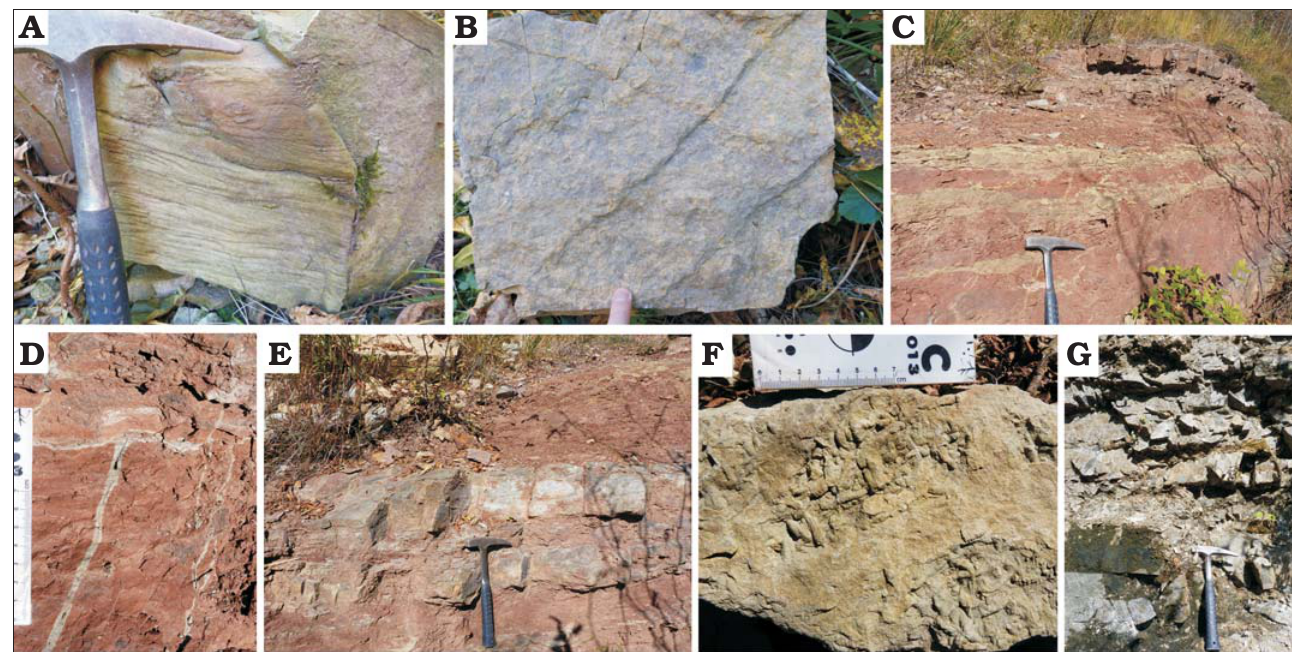
Fig. 2. Sedimentary structures of Val Gardena Sandstone. Facies association a, fine-grained sandstone showing cross lamination ( A ) and parallel ripples ( B ). Facies association b, reddish mudstone with paleosols ( C ), pedogenic veins and nodules in the mudstone ( D ). Note the gray dolostone strata on the top. Facies association c, gray dolostone strata interbedded in the reddish mudstone ( E ), invertebrate burrows in the dolostone ( F ). G . Bellerophon Formation, gray